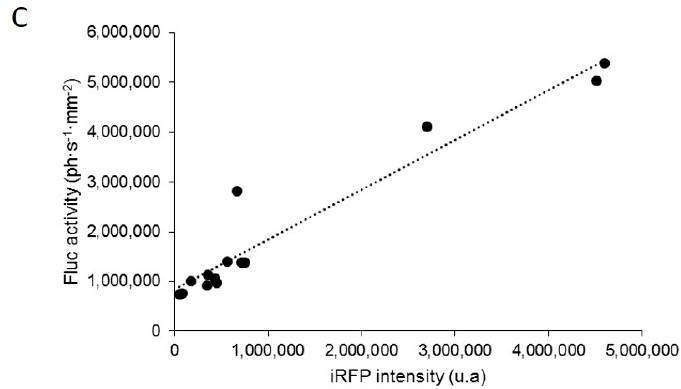
Figure 2. In vivo detection of Fluc activity and iRFP fluorescence by subcutaneous tumors U87-iRFP+-Fluc+. BLI ( A ) and FRI ( B ) of a representative mouse. Bioluminescence signals were plotted versus iRFP fluorescence signals ( C ) ( n = 8).